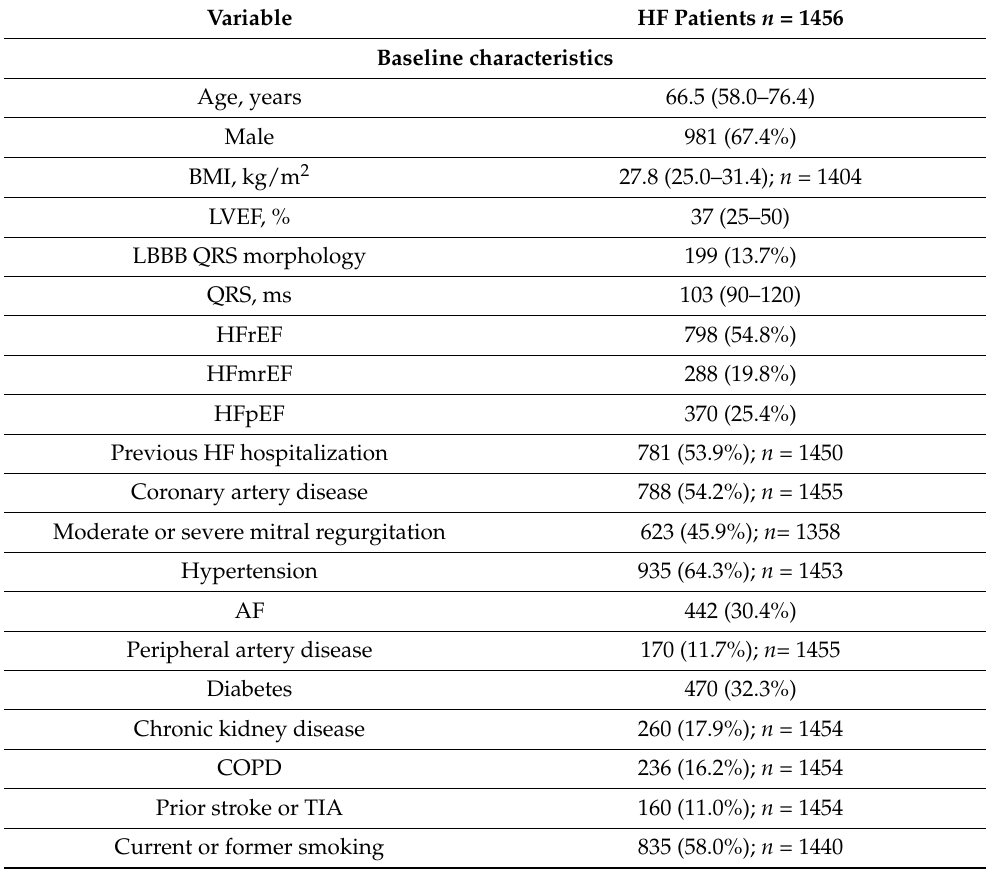
Table 1. Baseline characteristics of the study